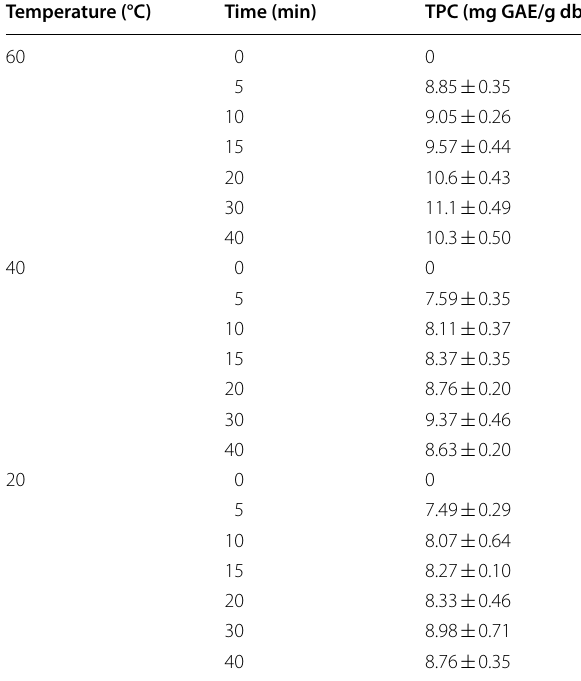
Table 4 Total polyphenolic compound (TPC) from apple pomace with 65% aqueous acetone–35% water v/v at solid/ solvent ratio of 1:100 g/mL, under continuous magnetic